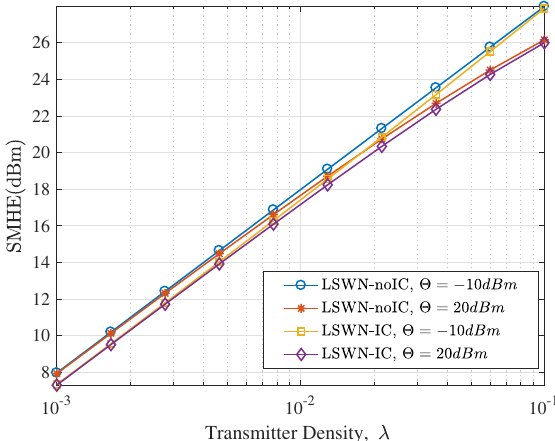
Figure 12. Spatial mean harvestable energy versus transmitter density with α = 4, d = 2, η a = 1 and P et = 30